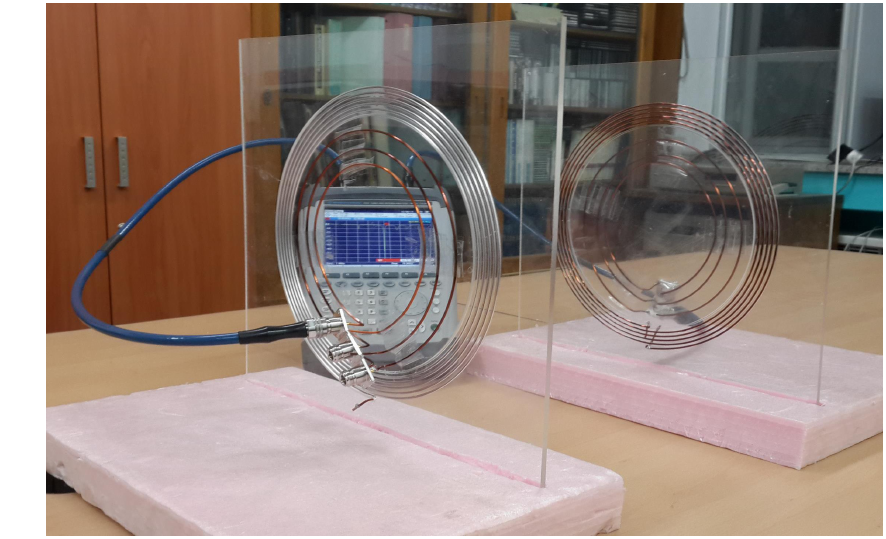
Figure 14. Fabricated resonators for the measurement